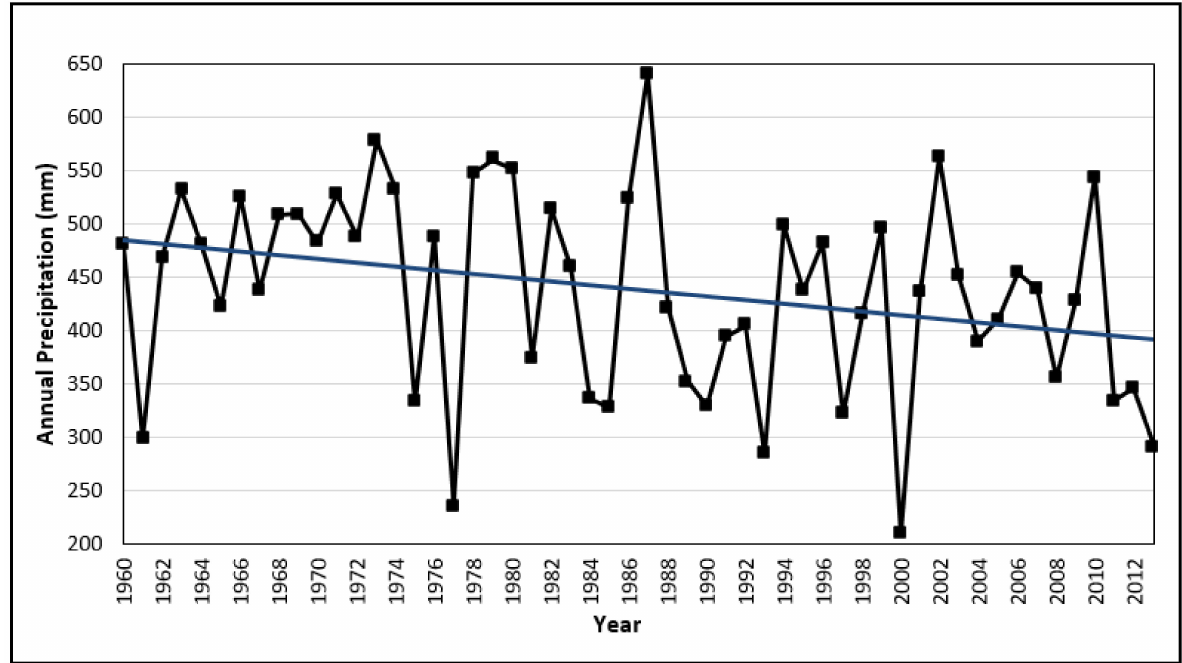
Figure 10. Annual precipitation between 1960 and 2013. The trendline shows the decreasing trend in annual precipitation in the